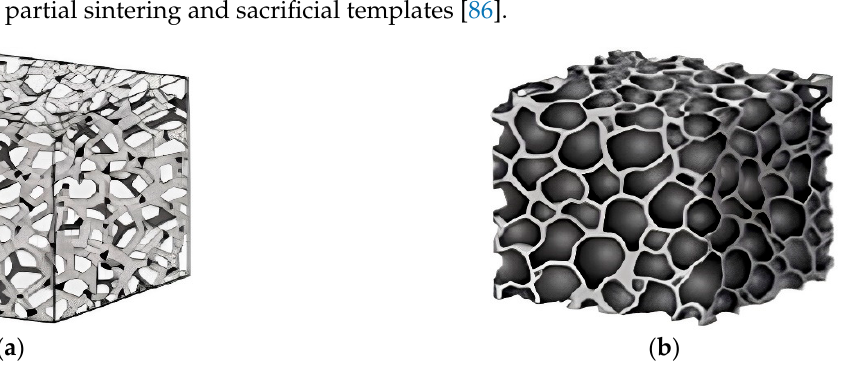
Figure 13. ( a ) Open pores of ceramic material; ( b ) Closed pores of ceramic material (Reprinted from Ref. [84], copyright (2007), with the kind permission of American Chemical Society).